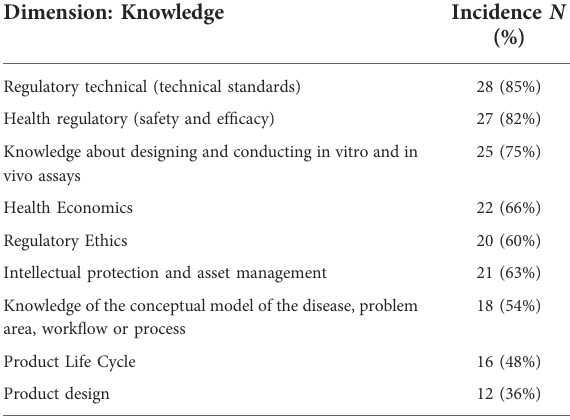
TABLE 1 Incidence of themes related to the attributes of translational research grouped by the Institutional